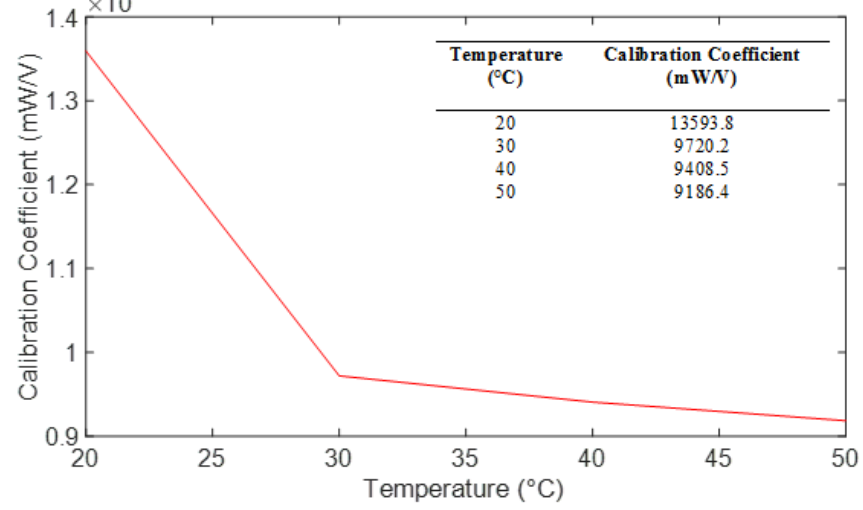
Figure 8. Calibration polynomial of the calorimeter.